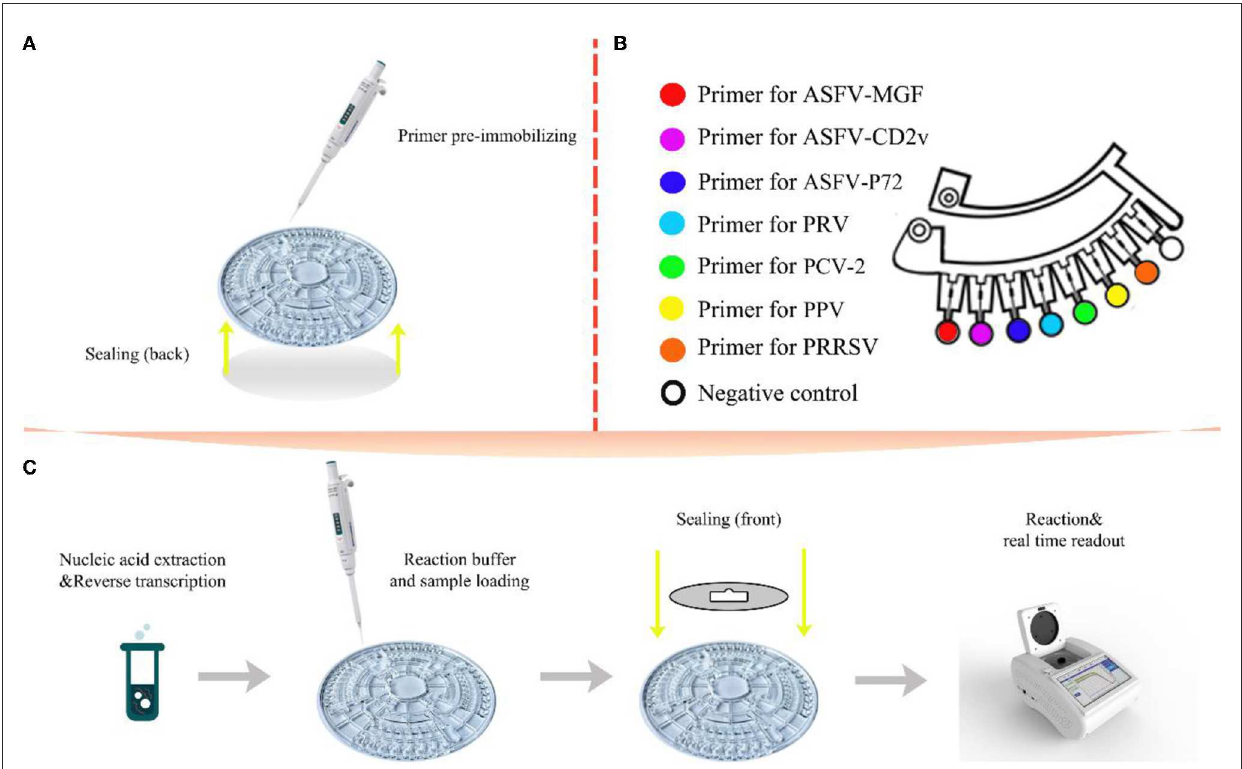
FIGURE2 Schematic illustration of the multiplex detection based on microfluidic-LAMP chip system. (A) Primer pre-immobilizing and back side sealing; (B) a single section of the chip with its reaction area; (C) the entire flow of the diagnosis on microfluidic-LAMP chip detection system.